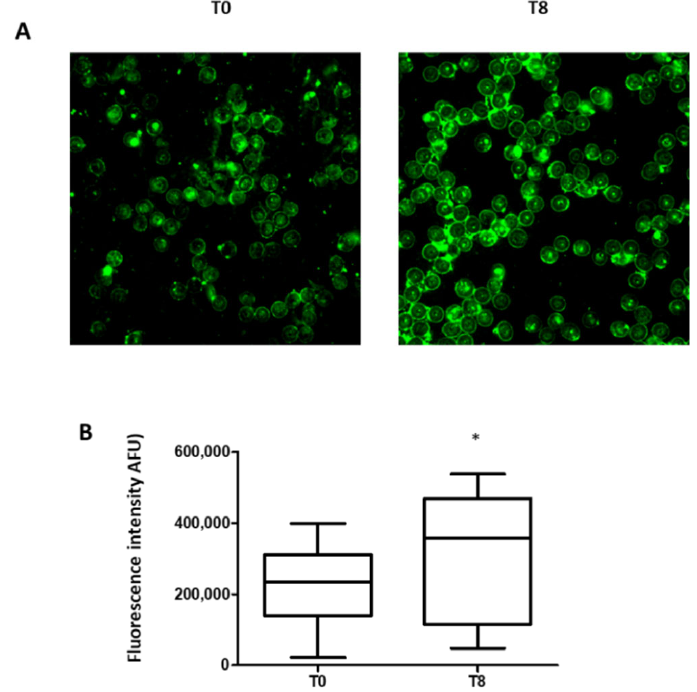
Figure 4. NO synthase expression. ( A ) Representative immunofluorescent images (630 × magnifica- tion) of RBCs isolated from prediabetic patients stained for RBC-NOS at baseline (T0) and at 180 min after an oral glucose load. ( B ) Quantitative analysis of RBC-NOS. Data are expressed as the mean of fluorescent intensity (AFU) ± SD subtracted of the negative control value (at least three fields were analyzed). n = 13; * p <